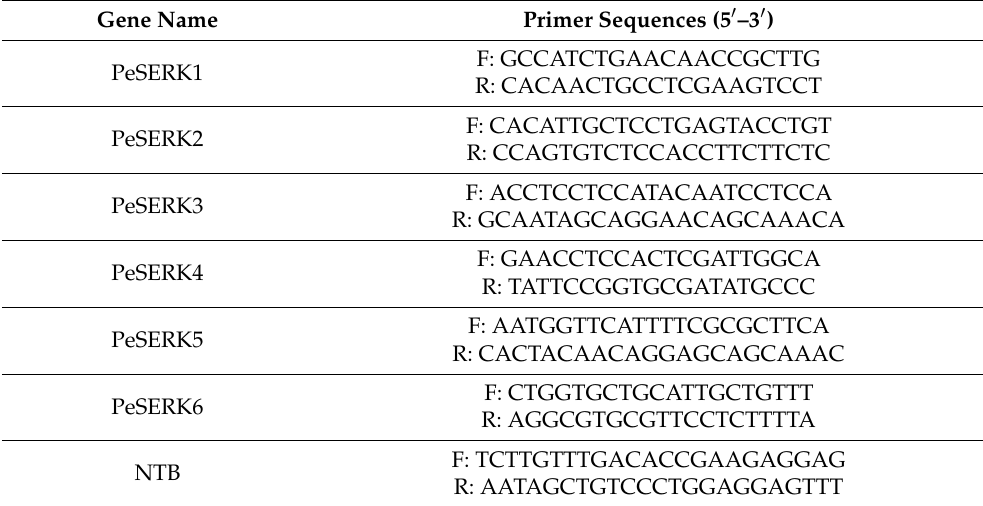
Table 1. Primers for